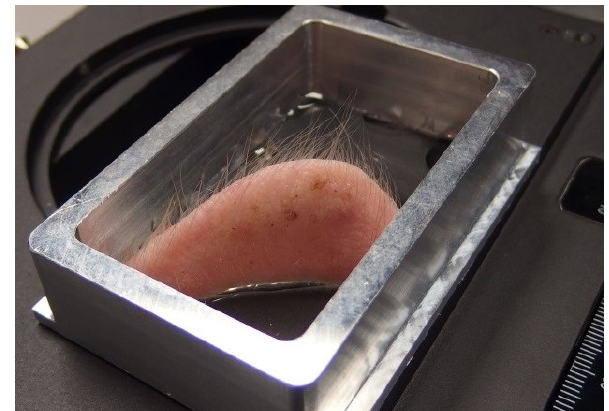
Figure 11. Porcine ear with the cut face down at the calcium fluo- ride plate of the Raman sample chamber.